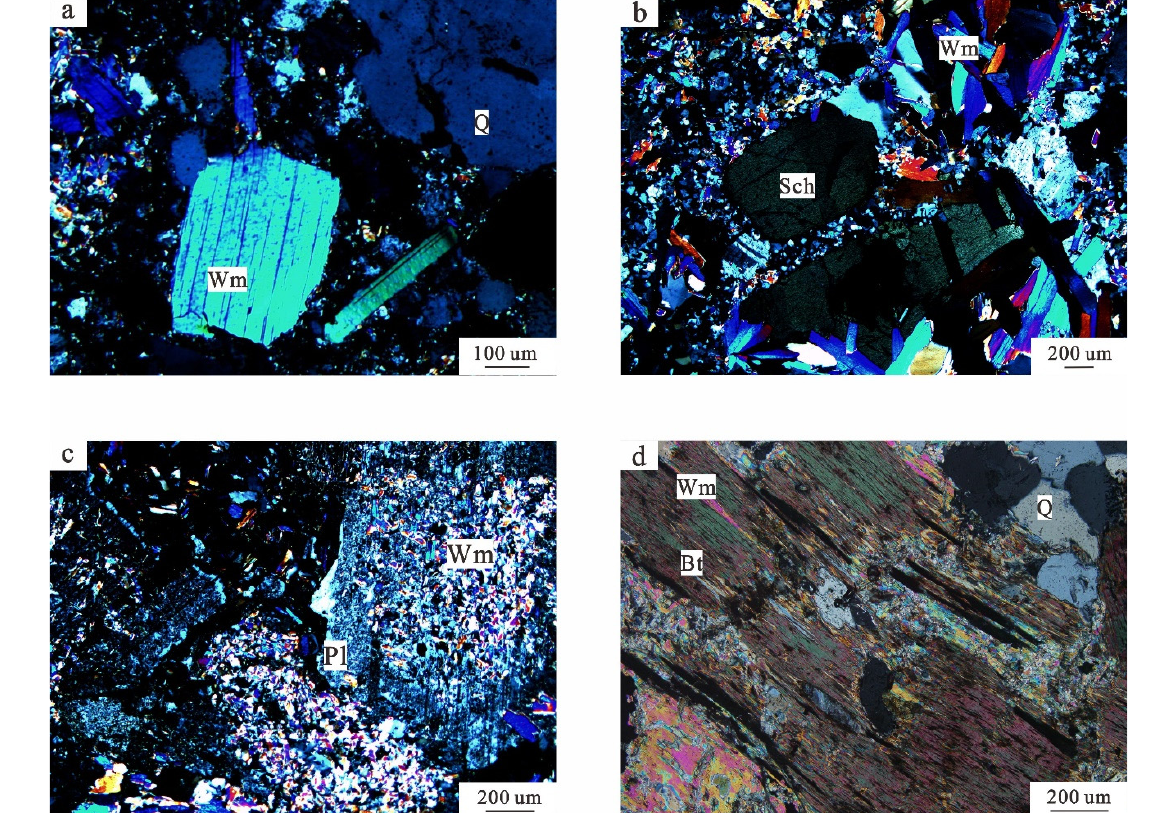
Figure 2. Photomicrographs of different types of white mica. ( a ) Flaky primary white micas; ( b ) White mica symbiotic with tungsten ore; ( c ) Feldspar-altered secondary white micas associated with scheelite; ( d ) White micas metasomatized by biotite (Bt—Biotite; Pl—plagioclase; Q—quartz; Sch—scheelite; Wm—white mica).